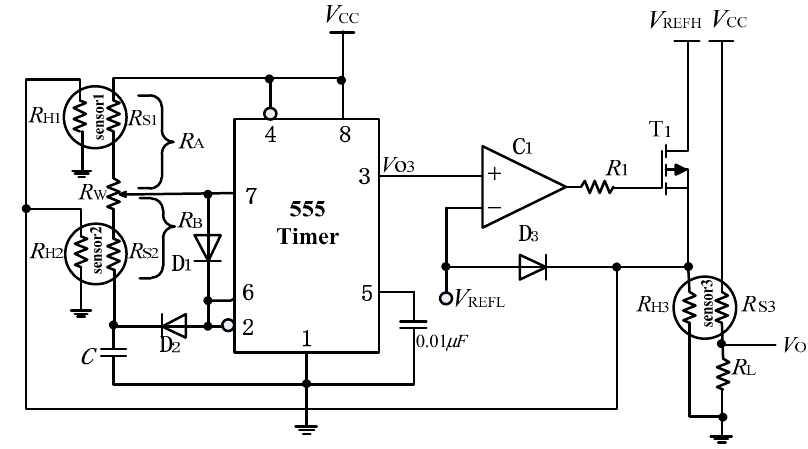
Figure 1. The measurement circuit. Sensor 1 is TGS2610, sensor 2 is TGS2610, and sensor 3 is TGS2620. V REFL and V REFH represent low and high reference voltage of heating voltage,